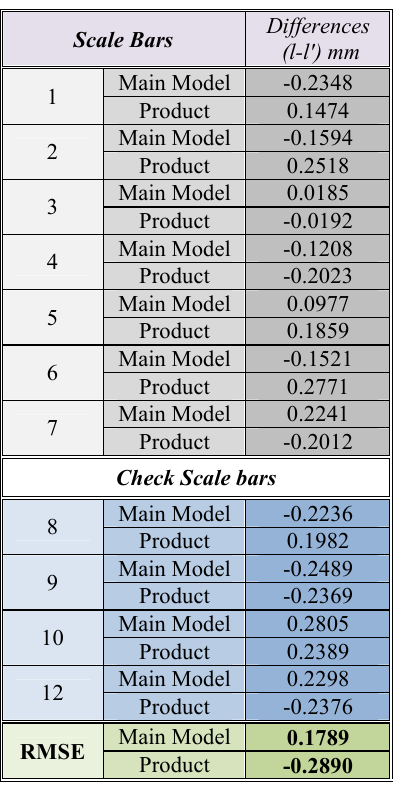
Table 6. Results for test of known